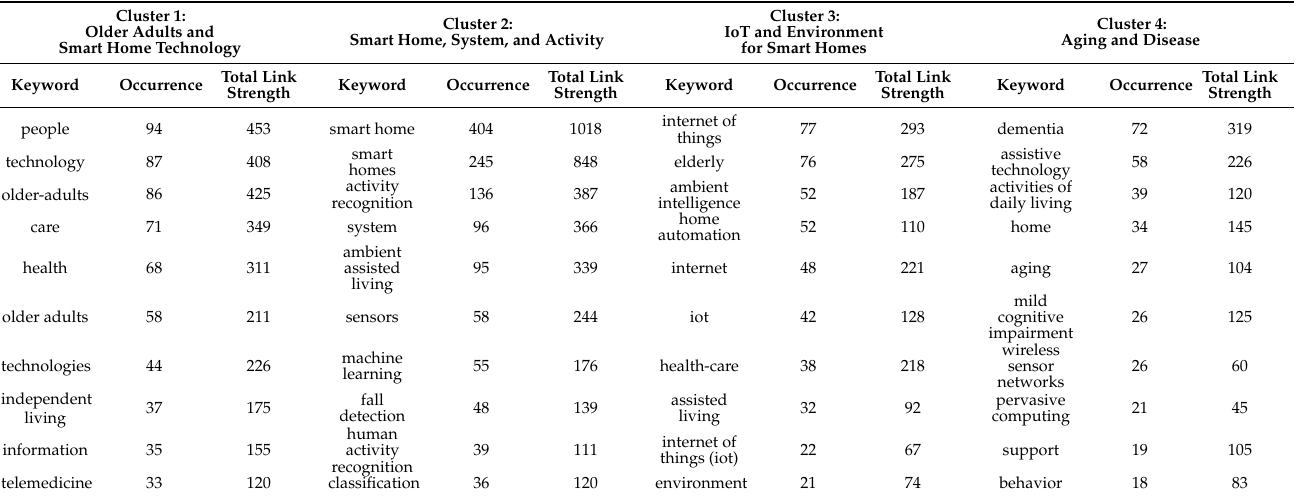
Figure 5. Co-occurrence network visualization. Table 7. Cluster and top 10